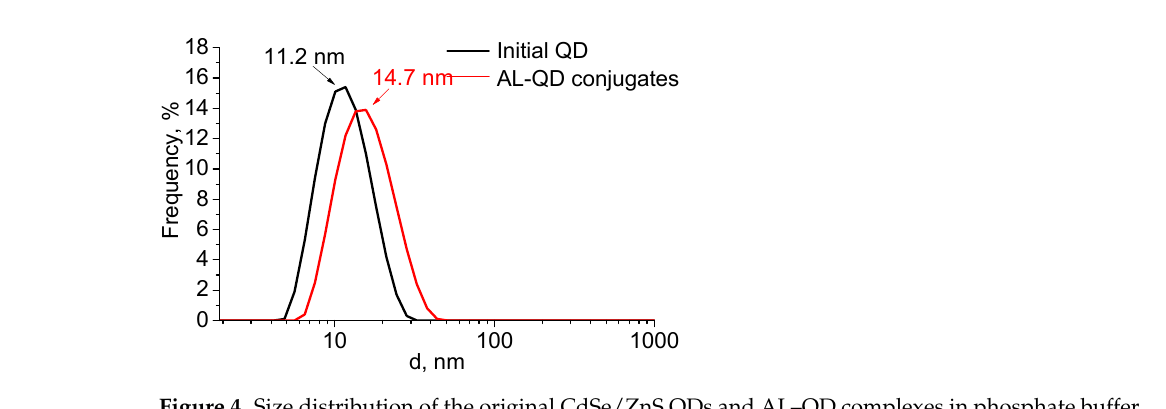
Figure 4. Size distribution of the original CdSe/ZnS QDs and AL–QD complexes in phosphate buffer (pH 8, 0.1 M).